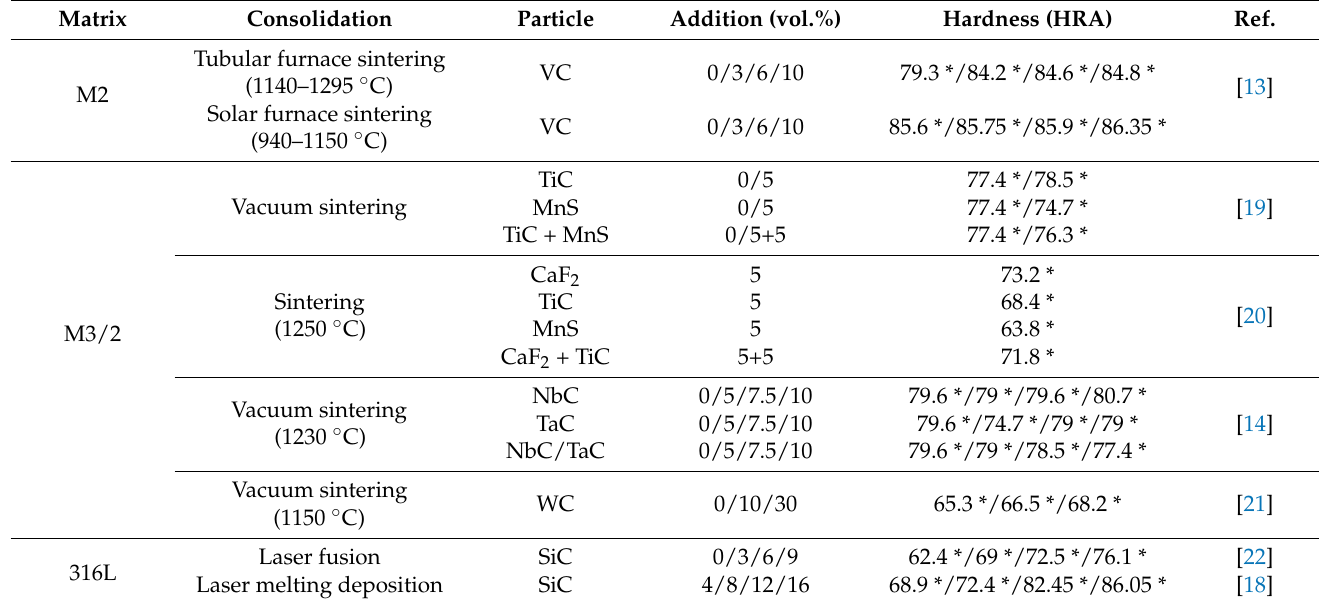
Table 1. The reported experimental results of various